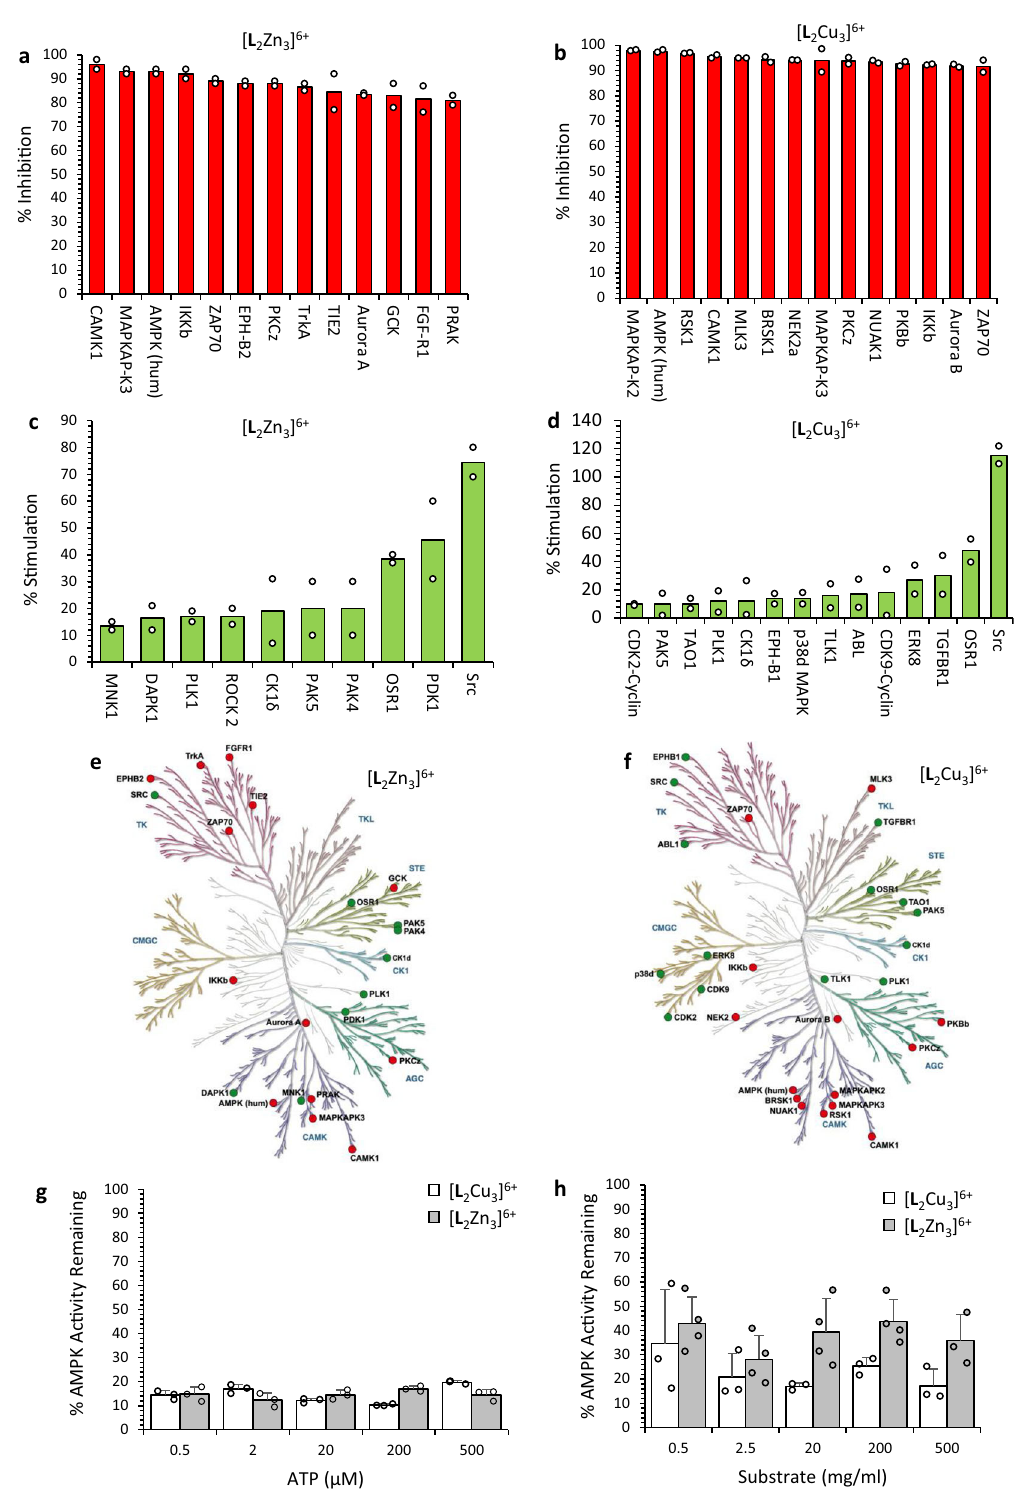
Fig. 7 Effects of [L 2 Zn 3 ] 6 + and [L 2 Cu 3 ] 6 + on the activity of puri fi ed human kinases. Percentage inhibition (red) of the indicated kinases by [ L 2 Zn 3 ] 6 + ( a ) and [ L 2 Cu 3 ] 6 + ( b ) respectively at a concentration of 10 μ M ( n = 2); full results are presented in the ESI. Kinases whose activity is stimulated (green) by [ L 2 Zn 3 ] 6 + ( c ) or [ L 2 Cu 3 ] 6 + ( d ) complexes. Kinome map showing kinases inhibited (red) or stimulated (green) by [ L 2 Zn 3 ] 6 + (n = 2) ( e ) or [ L 2 Cu 3 ] 6 + ( f ). Illustration reproduced courtesy of Cell Signalling Technology Inc (www.cellsignal.com). g , h AMPK kinase inhibition by [L 2 Zn 3 ] 6 + or [L 2 Cu 3 ] 6 + is non- competitive with ATP or substrate . g In fl uence of increasing ATP concentration (0.5 – 500 μ M) on the inhibition of AMPK kinase activity by [ L 2 Zn 3 ] 6 + or [ L 2 Cu 3 ] 6 + with the percentage of remaining kinase activity at each tested ATP concentration indicated. h In fl uence of increasing substrate concentration (1 – 15 mg/ml) on the inhibition of AMPK kinase activity by [ L 2 Zn 3 ] 6 + or [ L 2 Cu 3 ] 6 + with the percentage of remaining kinase activity at each tested substrate concentration indicated. Results in g and h are presented as mean ± SD from a minimum of three independent biological